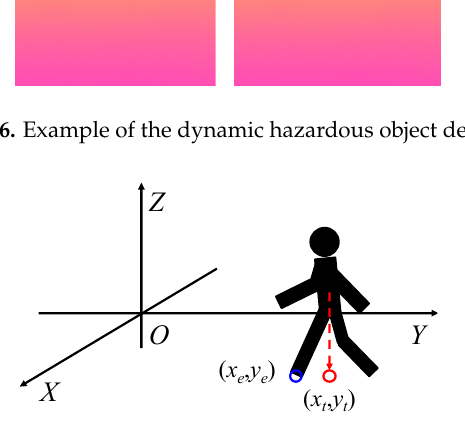
Figure 17. Reason of the average error in the dynamic hazardous object.